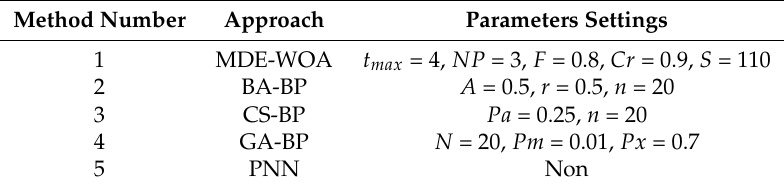
Table 2. Parameter setting in our study of various approaches.